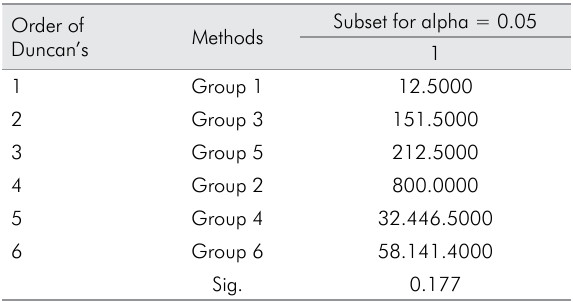
Table 4. Efficacy of all tested methods according to Duncan’s multiple range test.